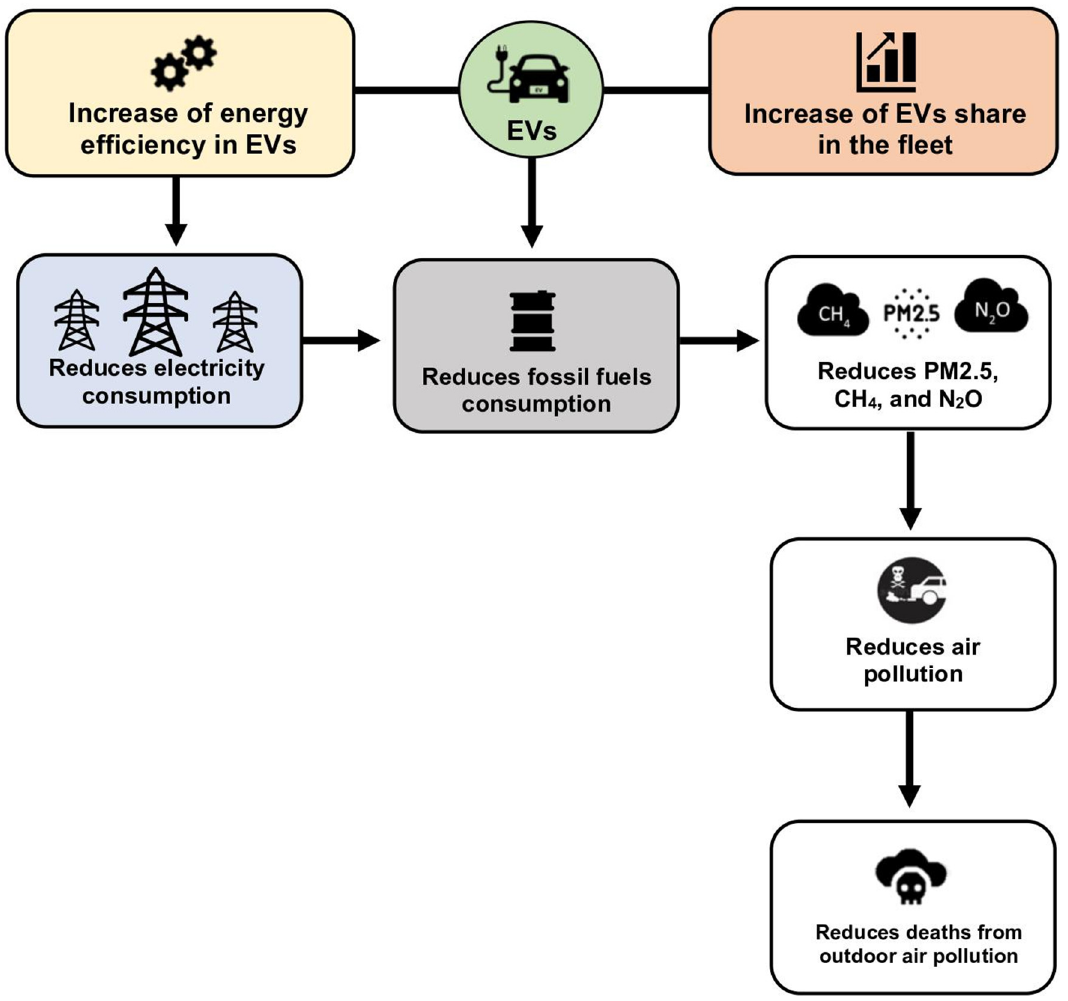
Figure 9. Summary of linkages. The authors created this figure.